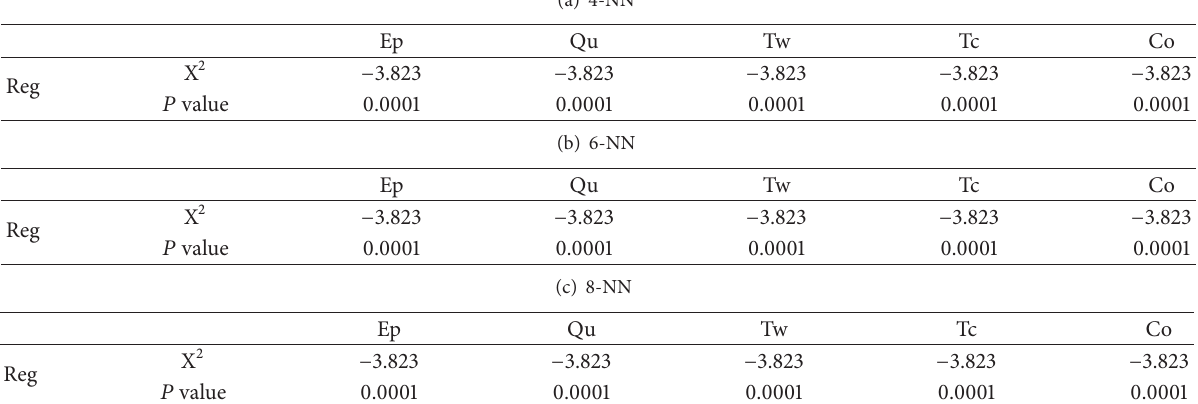
Table 3: Chi-square ( Χ 2 ) test with Wilcoxon signed rank method between regression and five different kernel methods.